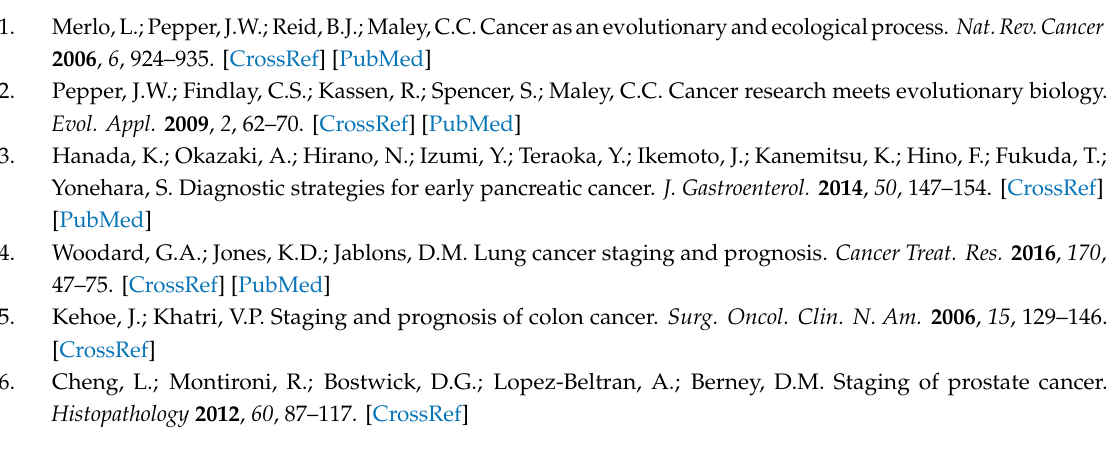
Figure S1: Samples and gene expression heatmaps, Figure S2: Prediction of the results of machine learning models and survival analyses, Figure S3: Correlation between number of genes and survival, Figure S4: Direction of changes in CNA and SGA, Figure S5: Forward and backward evolution and fine-tuning concepts, Figure S6: Common-Met and the heatmap of driver genes, Table S1: DEG lists, Table S2: Genomatix data, Table S3: CNA prototype map, Table S4: SGA density, Table S5: Networks and GSEA, Table S6: Homo / Hetero Nodes, Table S7: SPIA for DEG 1, 2, and 3, Table S8: Met-DEG, Table S9: SPIA for DEG 1, 2, and 4, Table S10: Driver